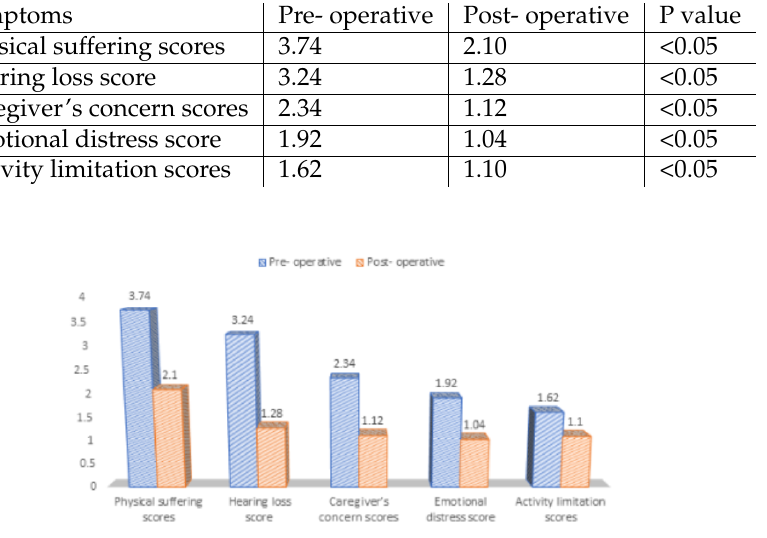
Figure 2. Graphical distrusting of comparison of scores calculated on visual analogue scale Pre-op mean air bone gap was 32.2 db and post- op mean air bone gap was 18.4 db. The difference was 13.8 decibels. A significant difference was observed (P< 0.05), see Table 4 and Figure 3. Table 4. Measurement of air bone gap